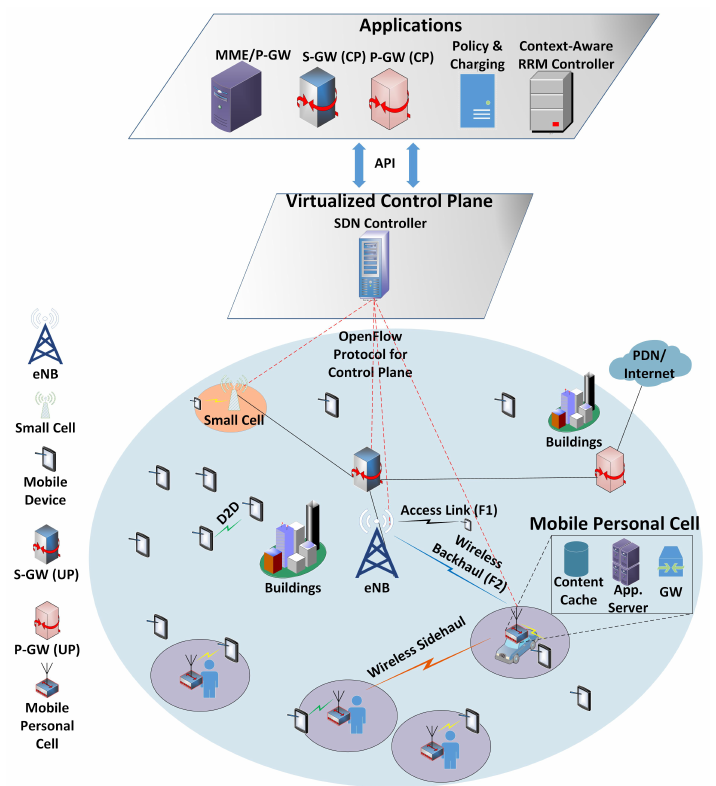
Figure 1. 5G system architecture with mPC deployed to fulfill the users’ emergency